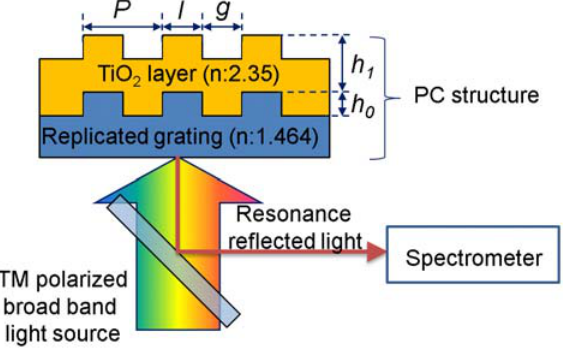
Figure 1. Schematic diagram of a PC structure composed of a replicated grating and a TiO layer. The method for detecting the resonance reflection peak is also 2